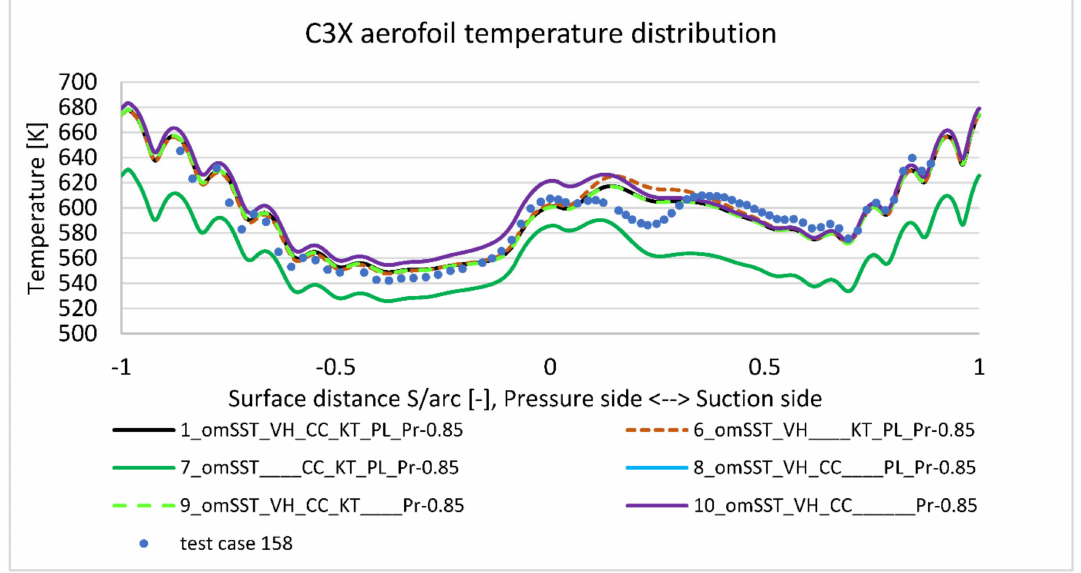
Figure 17. k-omega SST options temperature impact